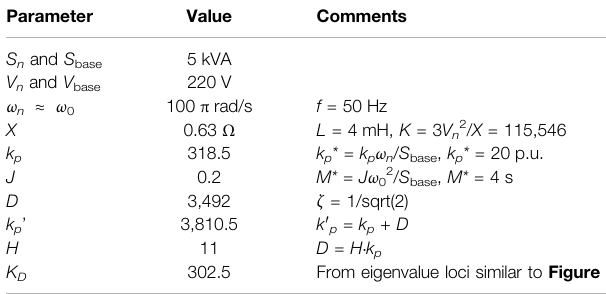
FIGURE 9 | Simulation results I: different VSG methods in the grid- connected mode.